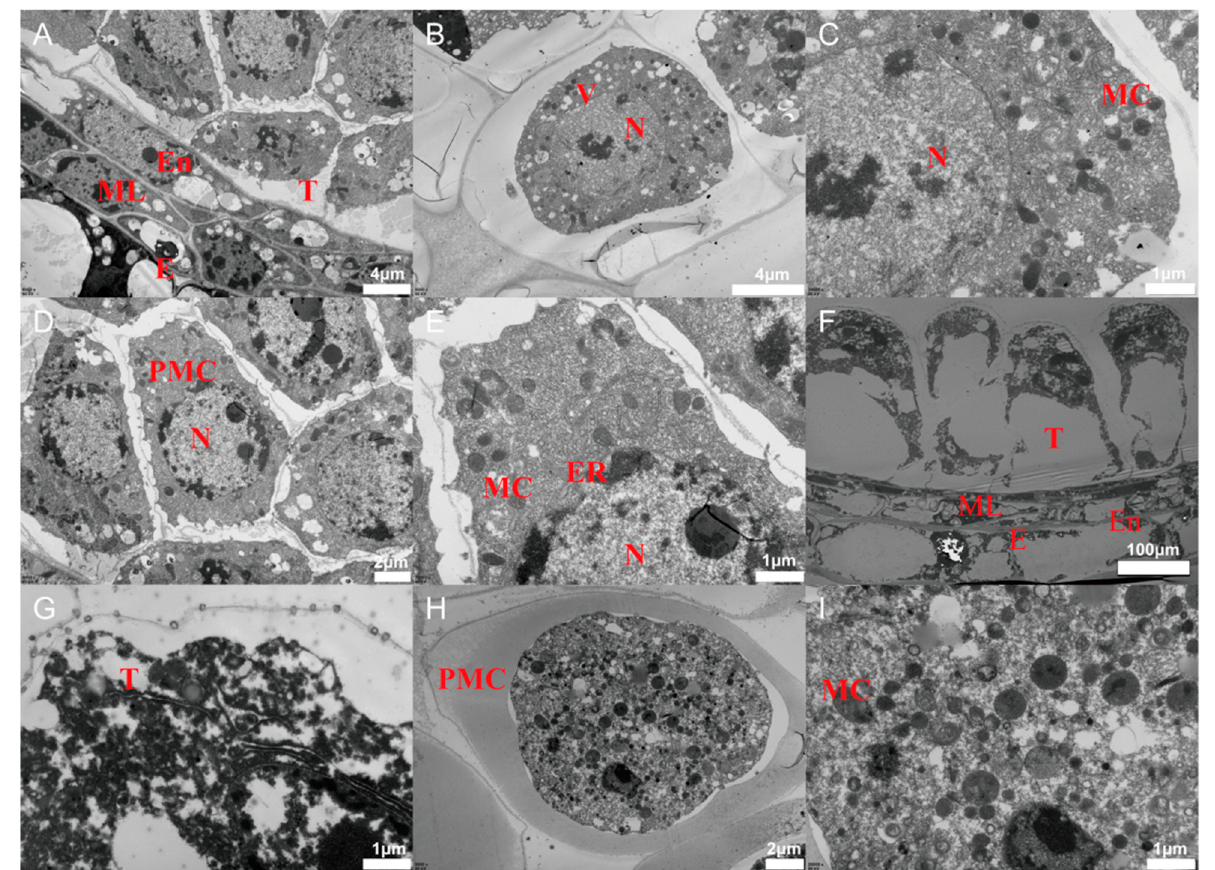
Figure 3. Anther ultrastructure of Ningqi No. 1 at Pm stage and Te stage. ( A ) Surface layer of pollen sac at Pm stage; ( B ) tapetal cell at Pm stage; ( C ) tapetal organelles at Pm stage; ( D ) pollen mother cell at Pm stage; ( E ) organelles in pollen mother cell at Pm stage; ( F ) anther surface layer at Te stage; ( G ) tapetal cells at Te stage; ( H , I ) pollen mother cell at Te stage. E, epidermis; EN, endothecium; ER, endoplasmic reticulum; MC, mitochondrion; ML, middle layer; N, nucleus; PMC, pollen mother cell; Po, pollen grain; SP, sporogenous cell; T, tapetum; Tds, tetrad; V, vacuole.